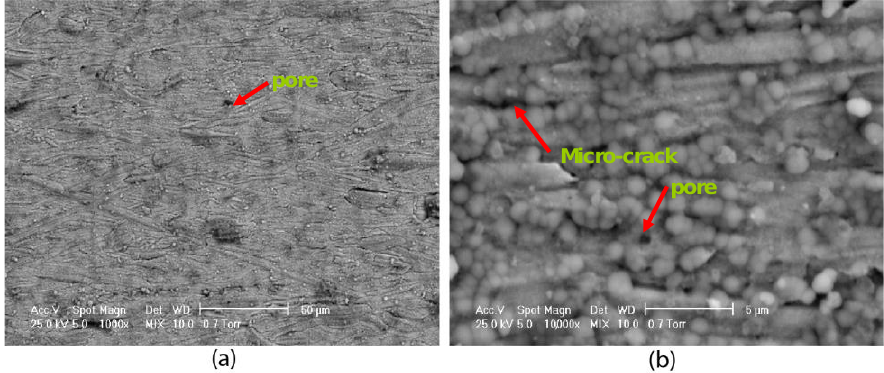
Figure 15. SEM morphology of the Co 0.12 Cr 0.55 Fe 0.11 Mn 0.1 Ni 0.12 film, sample 3: ( a ) ×1000; ( b ) ×10,000.